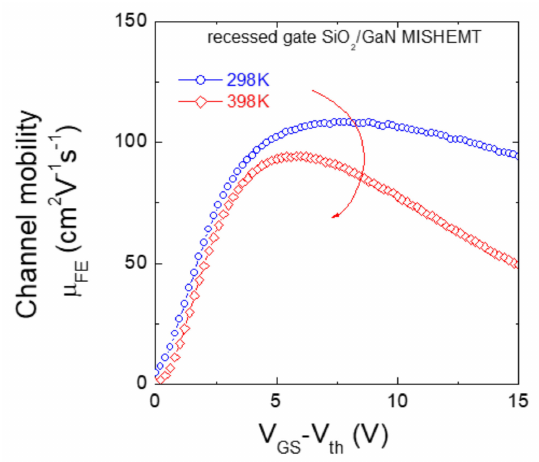
Figure 6. Field e ff ect channel mobility µ FE as a function of V GS –V th of a recessed gate SiO 2 / GaN MISHEMT, measured at room temperature (298 K) and at 398 K.